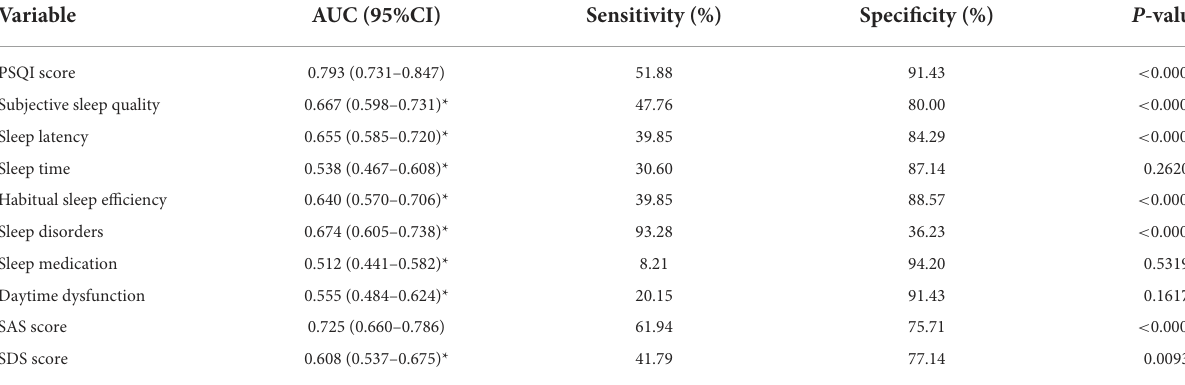
TABLE 4 ROC curve results of PSQI score and related indicators in predicting migraine. Variable